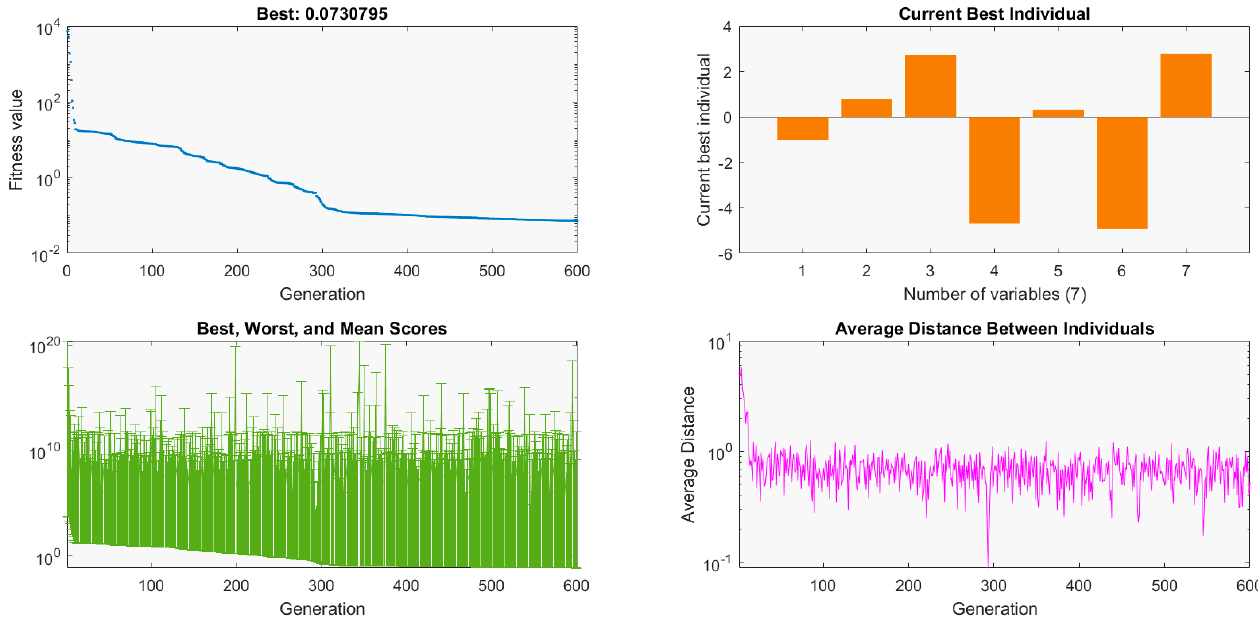
Figure 12. Results of Problem 2 in terms of learning curve, best individual scores, and average distance for 0.01 noise level.